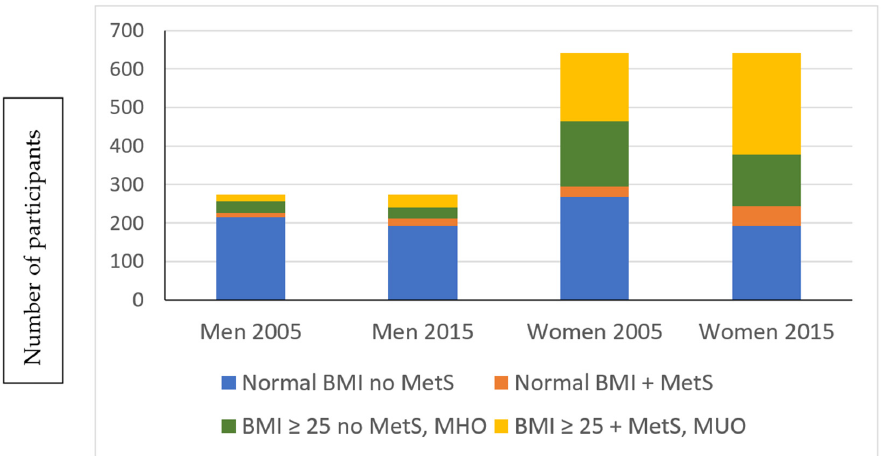
Figure 1. The distribution of participants among the four main BMI and metabolic health (MetS vs. no MetS) groups. BMI = body mass index, MetS = metabolic syndrome, MHO = metabolically healthy overweight/obesity, MUO = metabolically unhealthy overweight/obesity. Table 2 shows the baseline and follow-up characteristics according to different MHO and MUO categories. The age of participants who were MUO at baseline and maintained this condition was significantly older than the other three groups. The BMI and waist cir- cumference of the group who maintained MHNW were significantly smaller than the cor- responding values for the other groups, both at baseline and after 10 years. The MHO- MUO and MUOMUO groups had significantly larger waist circumference than the other groups in 2015. The metabolic profiles of the MHNW, MHO and MUO groups are com- pared in Table 2; differences are highlighted in Figure 2. Table 2. Characteristics of the study participants at baseline and follow-up according to BMI and metabolic syndrome (MetS) groups (MHNW vs. MHO or MUO).